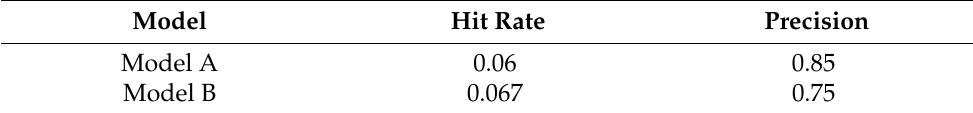
Table 5. The hit rate and the precision for the two hypothetical